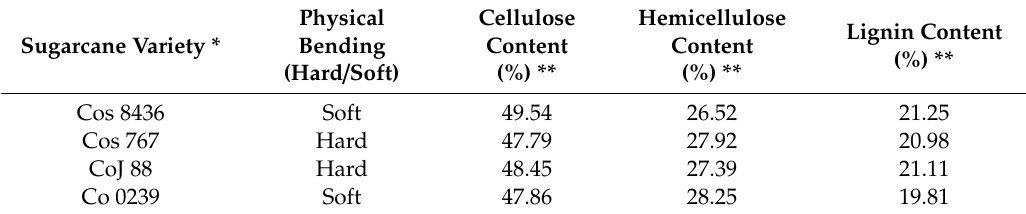
Table 1. Properties of di ff erent varieties of sugarcane bagasse fibre obtained from sugarcane.